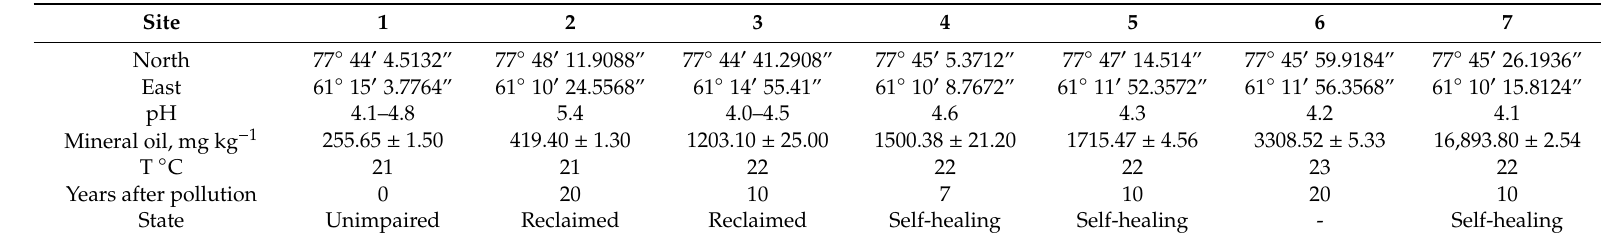
Table 1. Averaged chemical variables in the studied sites of the sphagnum bogs of the Ershov oil field in the Vakh River with geographical coordinates, year of impact, and rehabilitation